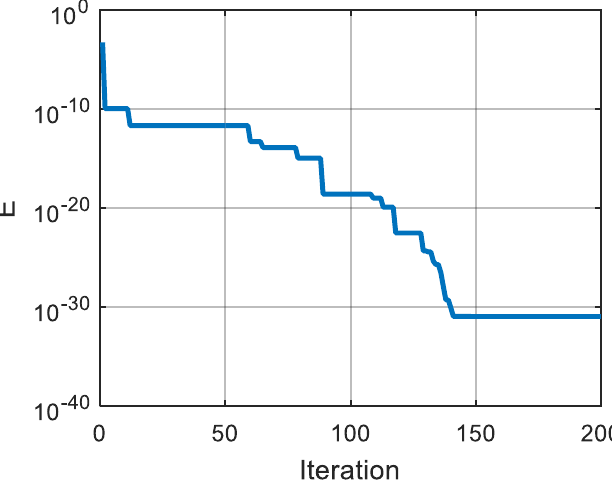
Figure 5. Change of minimum angle error during 200 iterations.